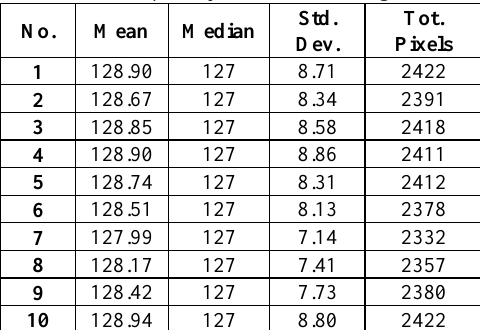
Table4. Magic Wand process on Homomorphicaly Filtered Test Image#2